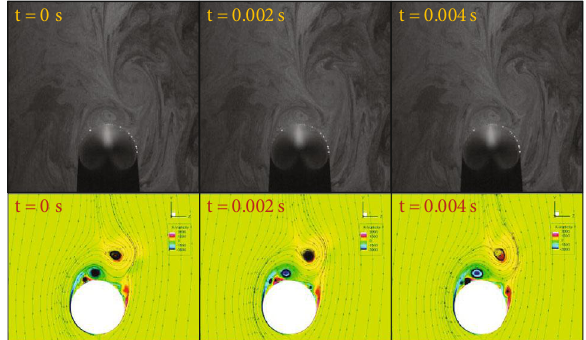
Figure 14: There is no obvious di ff erence in fl ow fi eld